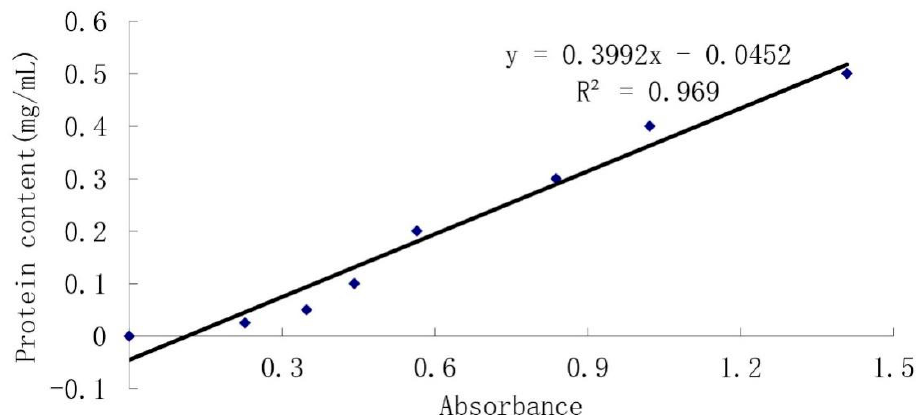
Figure 2. Standard curve of determining protein content by BCA method.